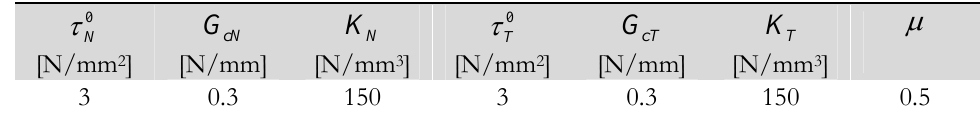
Tabella 1: Parametri di interfaccia del modo I e del modo II.